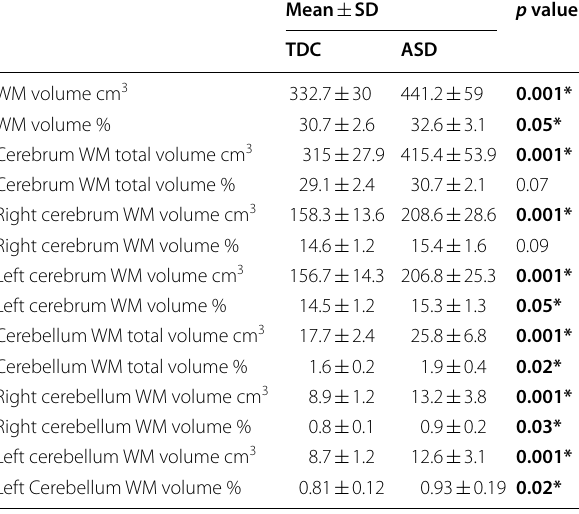
Table 3 Comparing different brain regions’ mean volumes between TDC and ASD groups